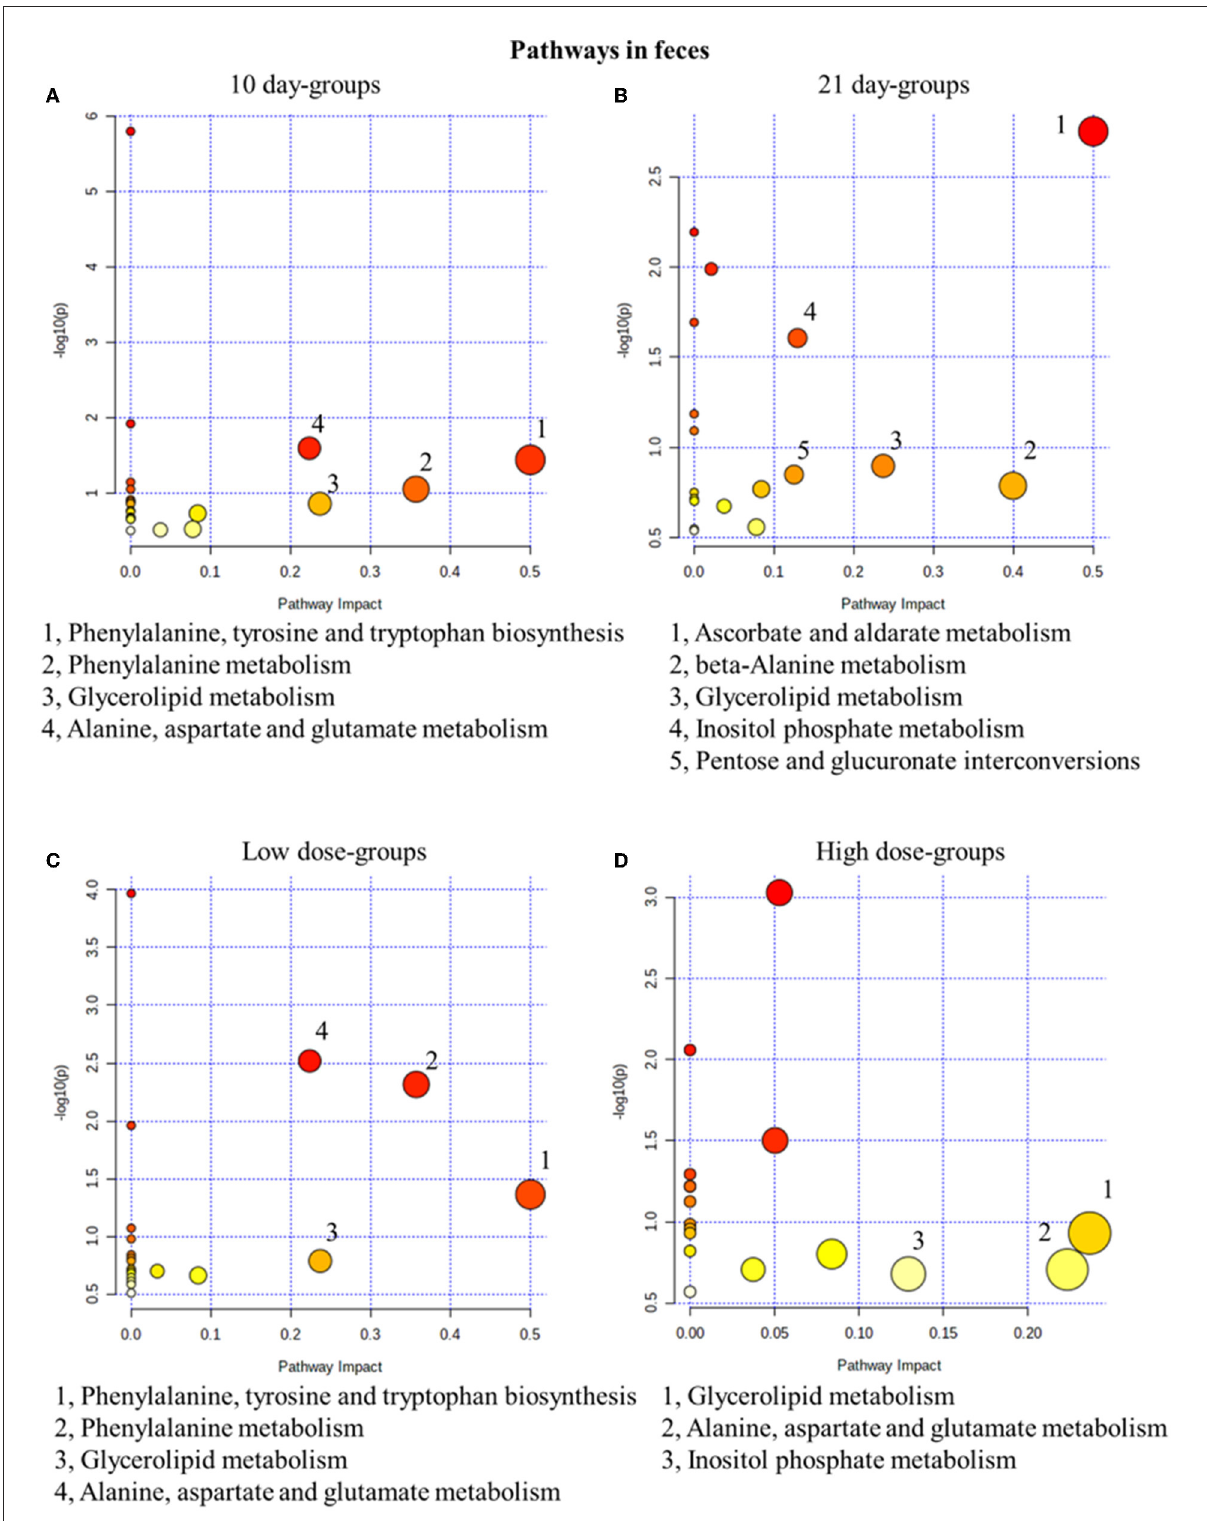
FIGURE5 Metabolic pathway analysis of fecal samples with different groups. (A) Pathways of low-dose and high-dose groups on the 10th day. (B) Pathways of low-dose and high-dose groups on the 21th day. (C) Pathways on the 10th day and 21st day of low-dose groups. (D) Pathways on the 10th day and 21st day of high-dose